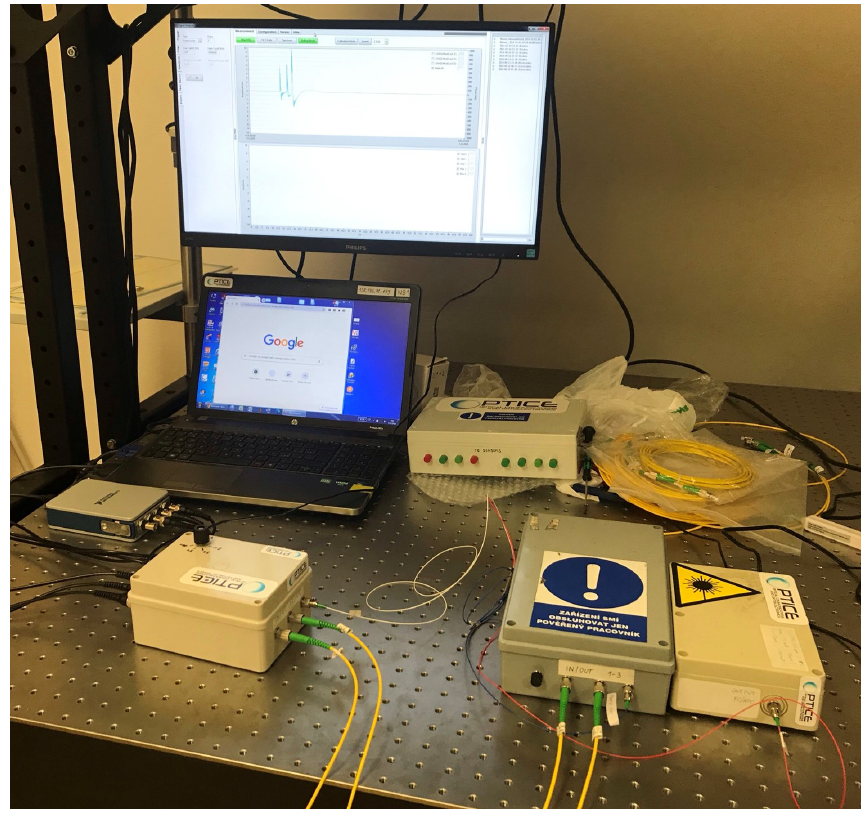
Figure 3. Example of connection of the fiber-optic interferometer and the sensor system.